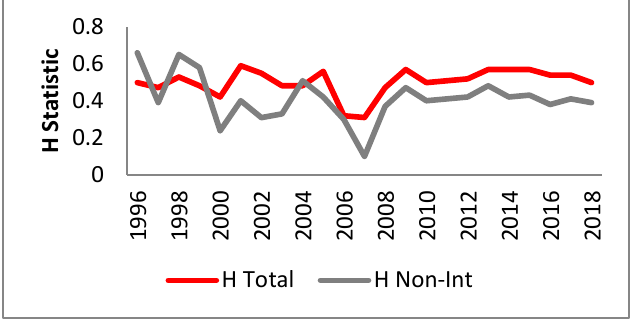
Figure 3: H Statistics: Non-interest Revenue Vs Total Revenue 1996-2018; Source: Calculations by the